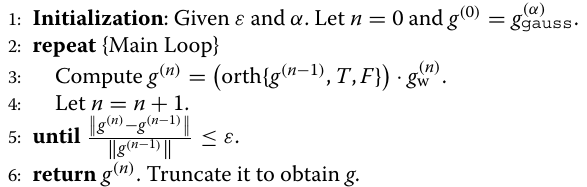
Algorithm 1 Iterative algorithm for constructing OFDM- based pulses with arbitrary length